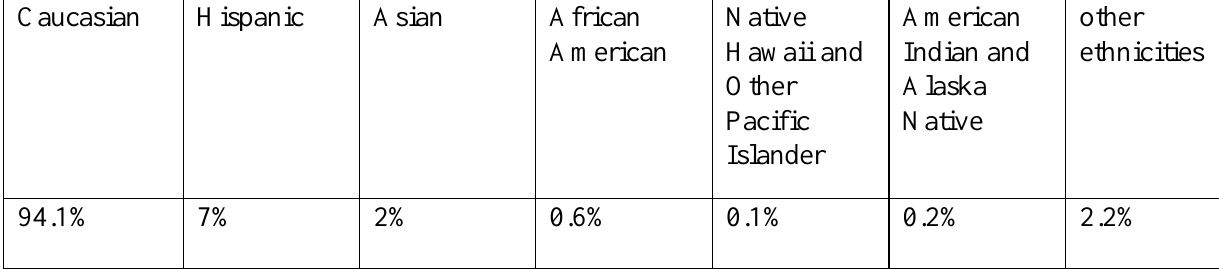
Population Racial/Ethnic Background by Percentage in the Community Caucasian